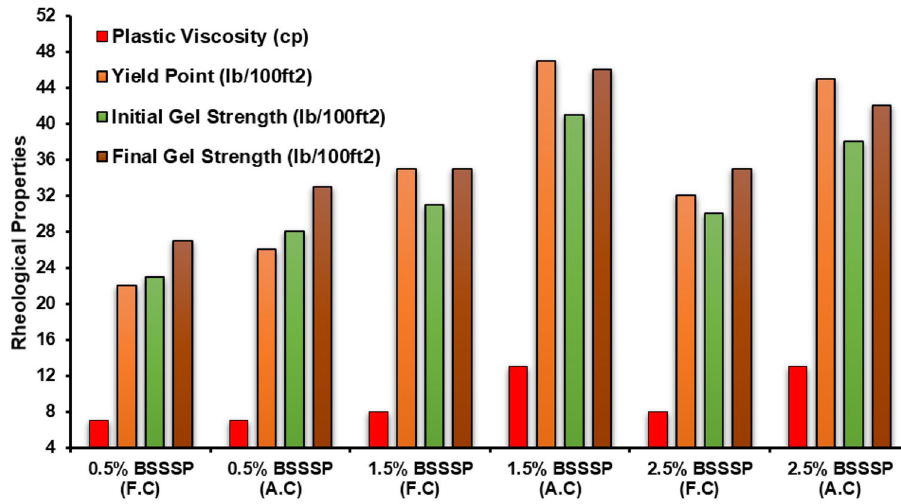
Fig. 7 Comparison between the effects of BSSSP on the rheo- logical properties under fresh and aged conditions